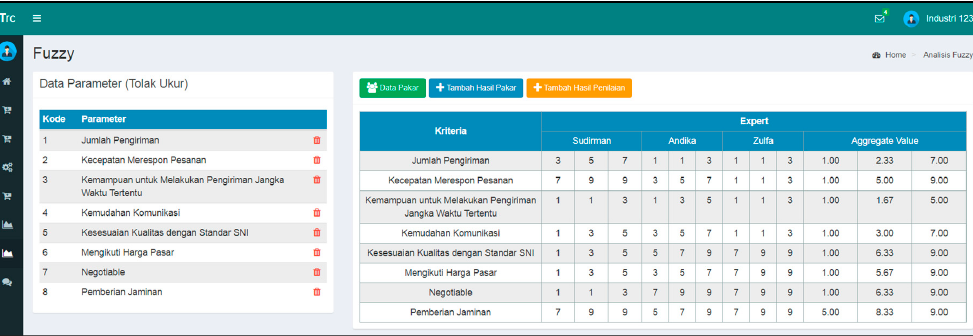
Figure A5. The page for supplier selection uses fuzzy TOPSIS.